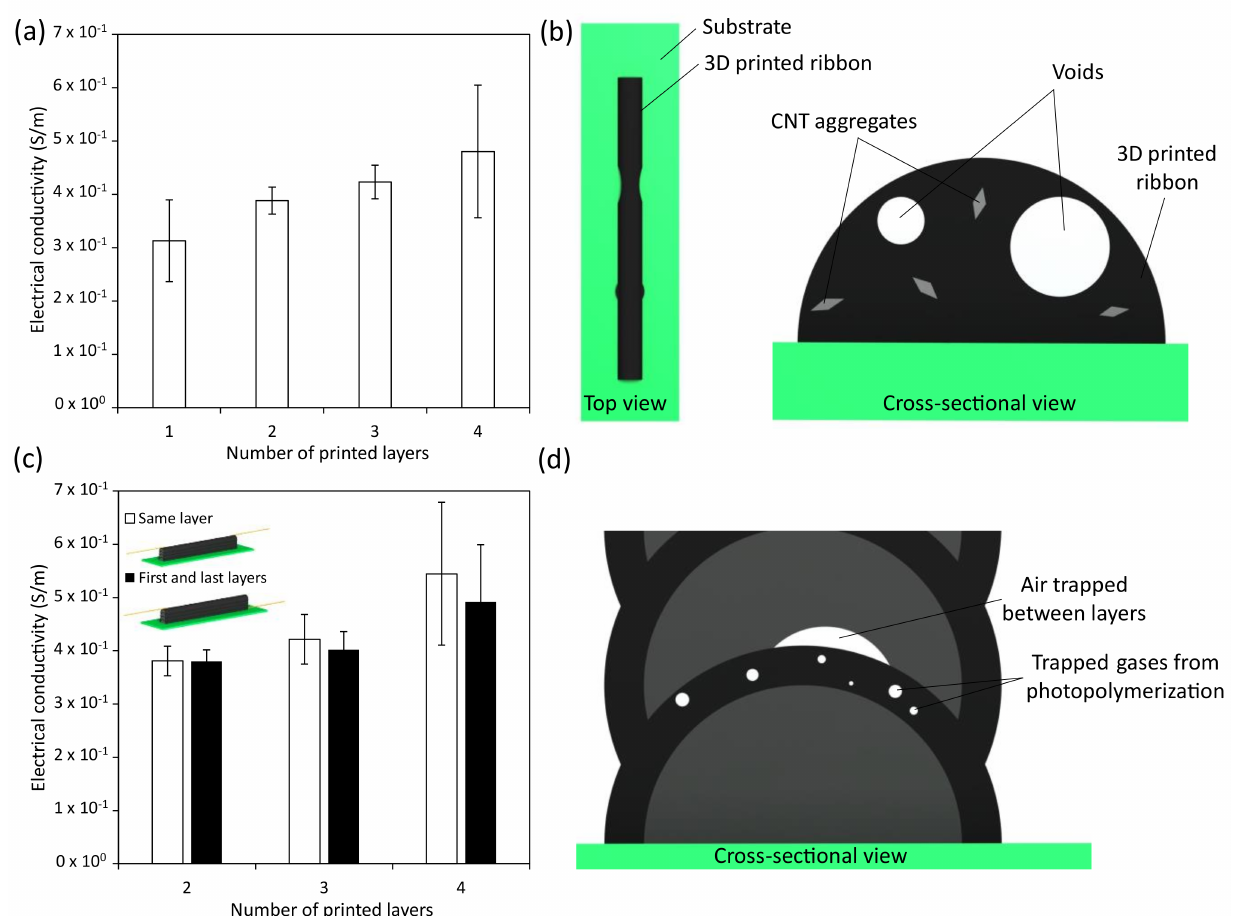
Figure 6. Electrical conductivity tests. ( a ) electrical conductivity of the circuits as a function of number of printed layers, ( b ) local heterogeneities that can hinder the formation of the electrically conductive network, ( c ) electrical conductivity of the ribbons as a function of electrode disposition and the number of printed layers and ( d ) scheme of air trapped between printed layers and trapped gases from the photocuring